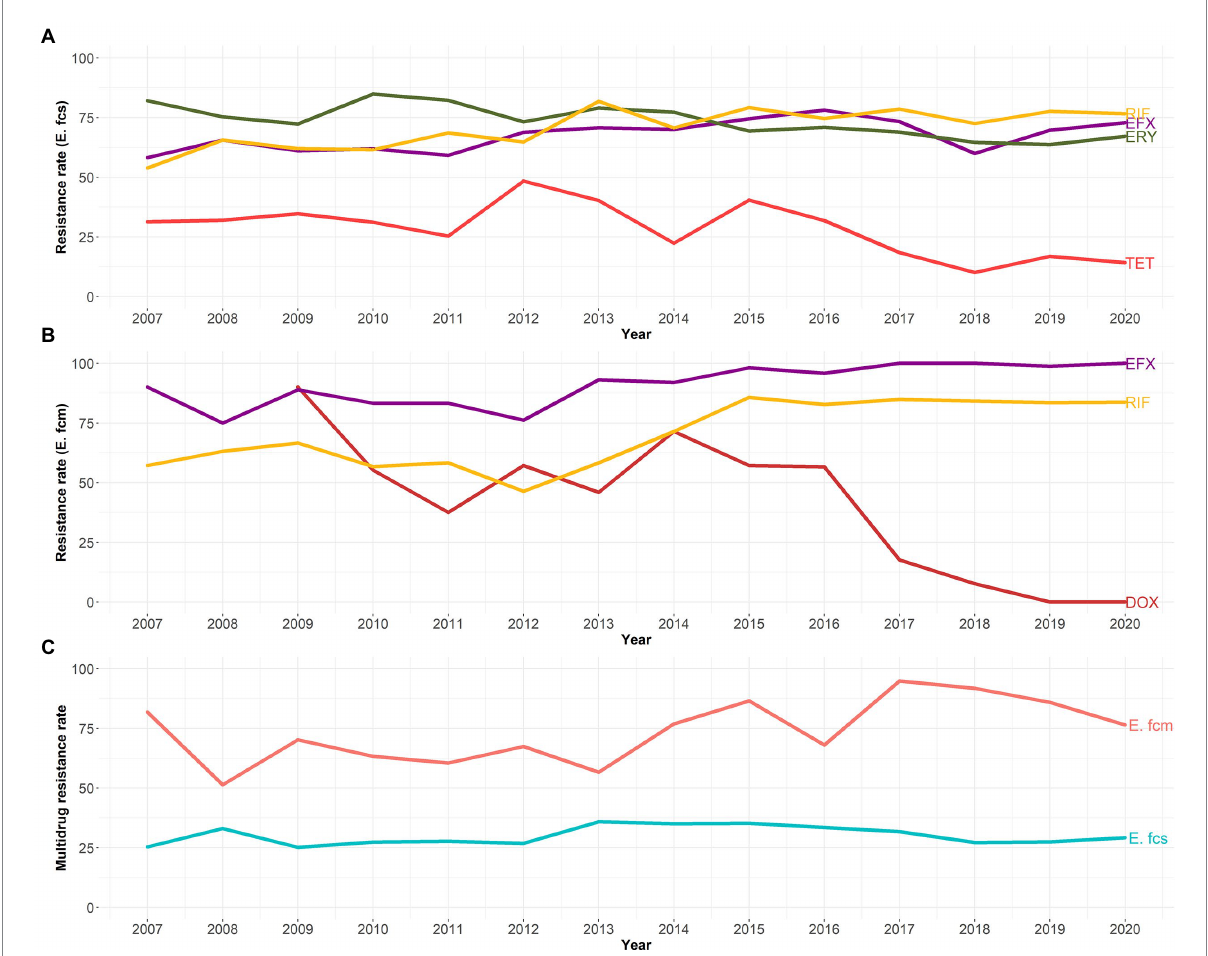
FIGURE 3 Temporal trends in the prevalence of resistance to tetracycline (TET), doxycycline (DOX), erythromycin, enrofloxacin (EFX), and/or rifampin (RIF; A , B ), and multidrug resistance (C) among canine Enterococcus faecalis ( E. fcs ) and Enterococcus faecium ( E. fcm ) isolates during the study period (2007–2020), in canine clinical infections at the Cornell University Animal Health Diagnostic Center (AHDC),